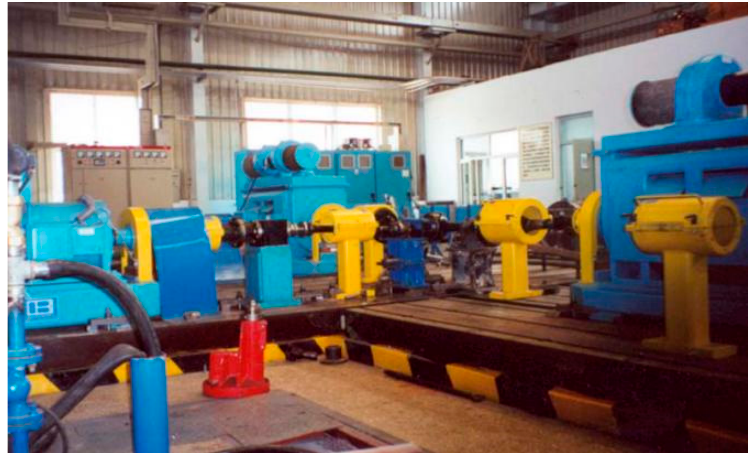
Figure 9. Testing field of VLSD.